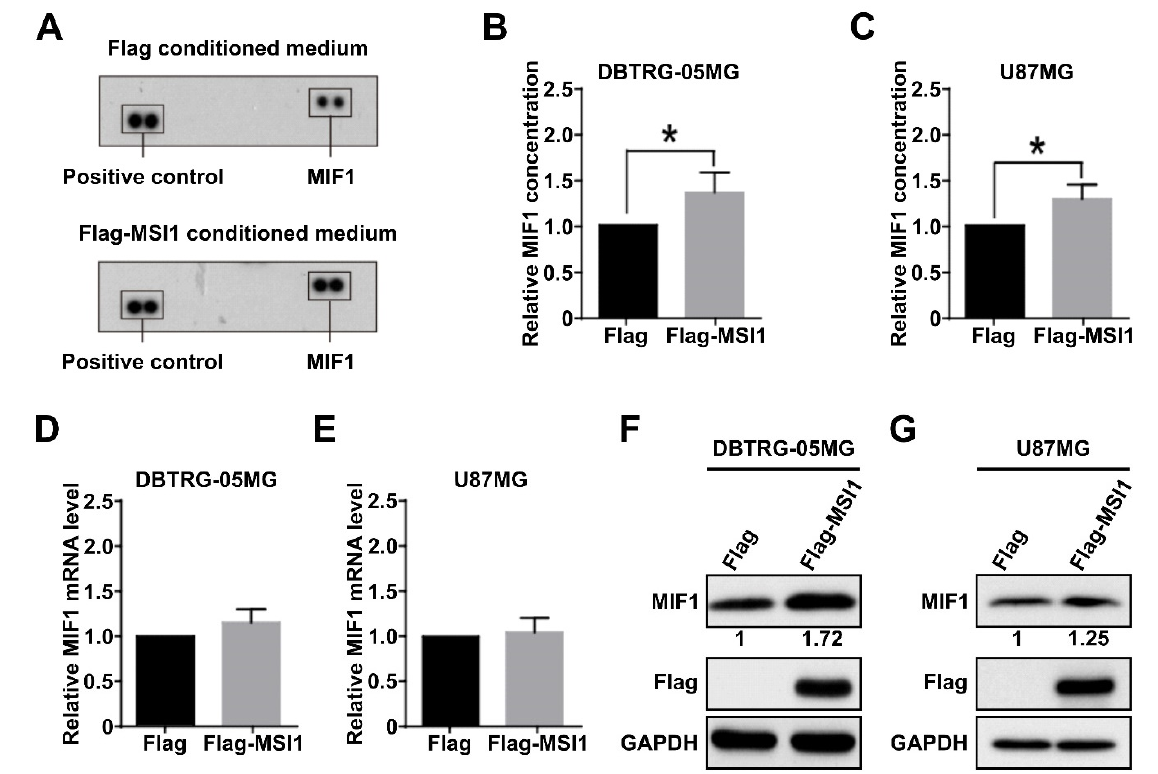
Figure 1. Musashi-1 overexpression in GBM cells elevates MIF1 expression and secretion. ( A ) Cytokine array analysis showing the level of MIF1 in the medium conditioned by the DBTRG-05MG cells overexpressing Flag–MSI1 (bottom panel). The top panel shows results from the cells transfected with a control Flag-only plasmid. ( B , C ) ELISA analysis showing the levels of MIF1 in the medium conditioned by the DBTRG-05MG ( B ) or U87MG ( C ) cells overexpressing Flag–MSI1. Mean values relative to the Flag-only control are shown, n = 3, SD—error bars, * p < 0.05 (Student’s t -test). ( D , E ) Quantitative RT-PCR analysis showing the expression of MIF1 mRNA in the DBTRG-05MG ( D ) or U87MG € cells overexpressing Flag–MSI1. Mean values relative to the Flag-only control are shown, n = 3, SD—error bars. ( F , G ) Western blotting showing the protein level of MIF1 in the DBTRG-05MG ( F ) or U87MG ( G ) cells overexpressing Flag–MSI1. Numbers under the top panel show densitometry quantification of MIF1 bands. GAPDH was used as a loading control.